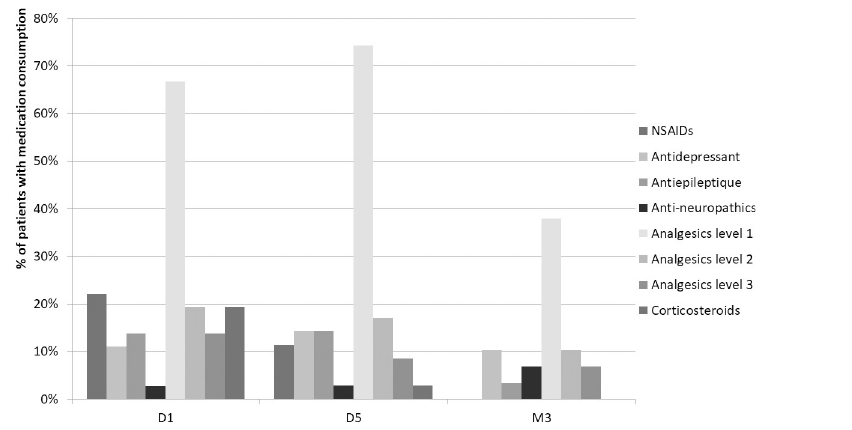
Fig 5. Change in medication consumption.